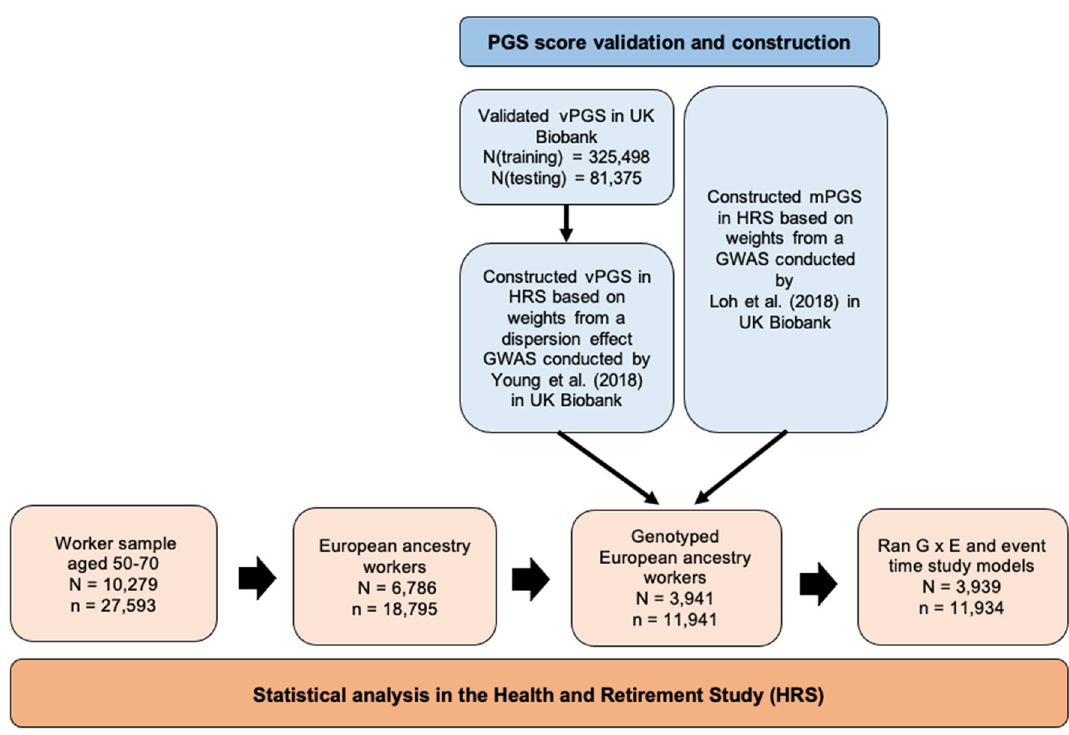
Figure 1. Analytic workflow in the UK Biobank and the Health and Retirement Study